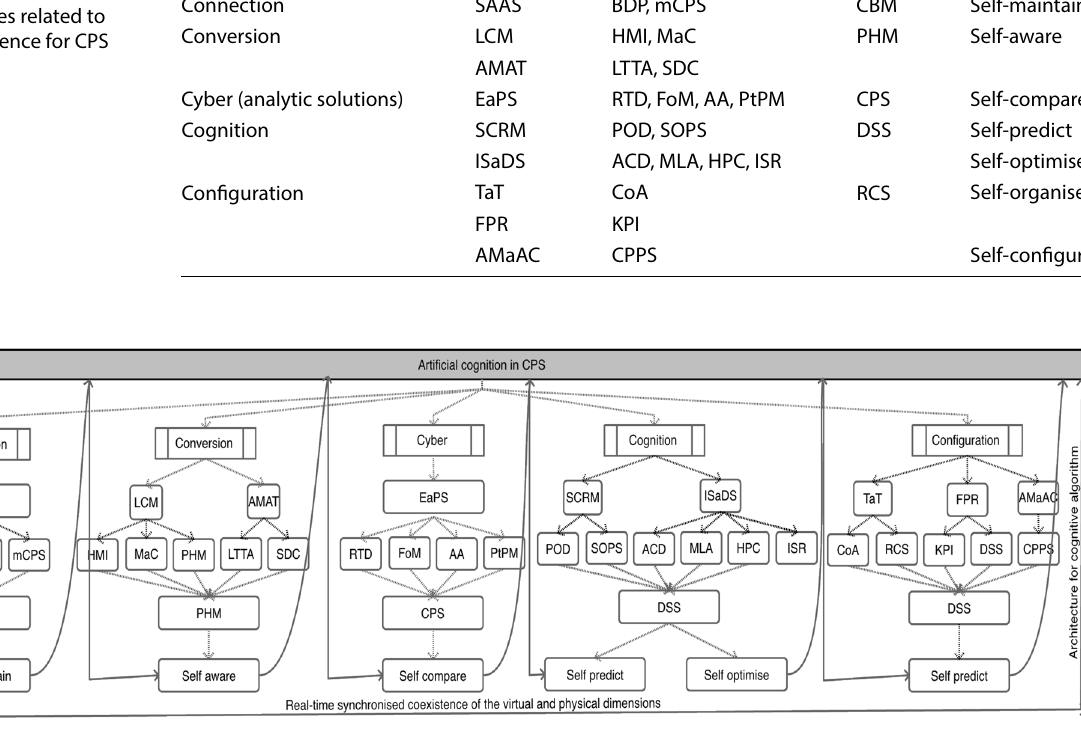
Fig. 2 Cascading framework for artificial intelligence for